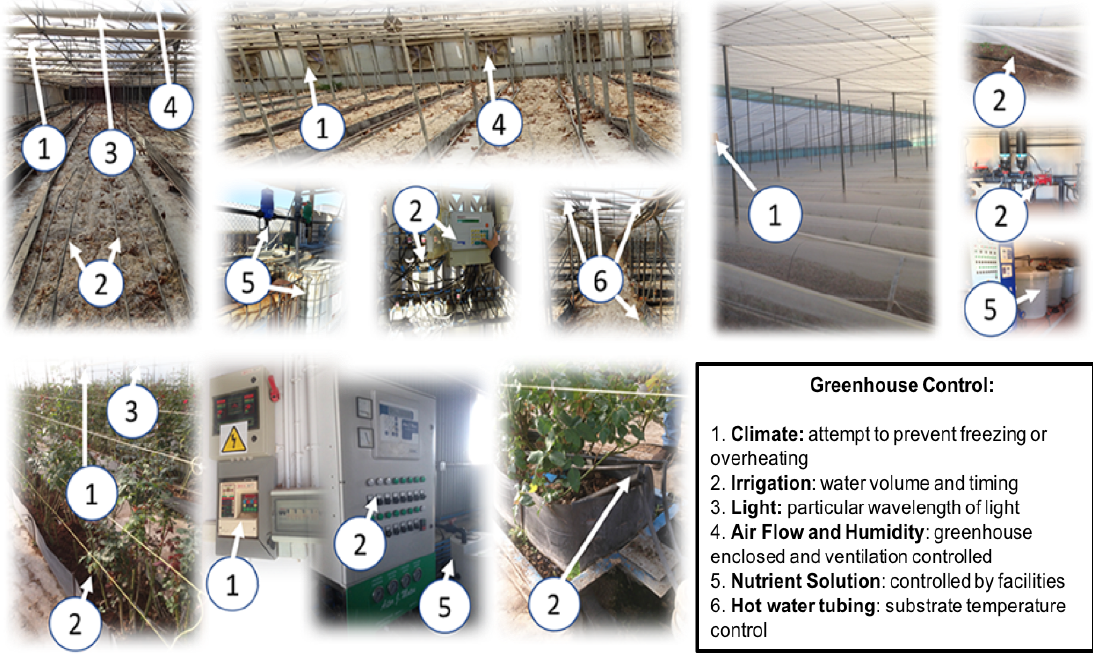
Figure 2. Automated greenhouses: main subsystems in current